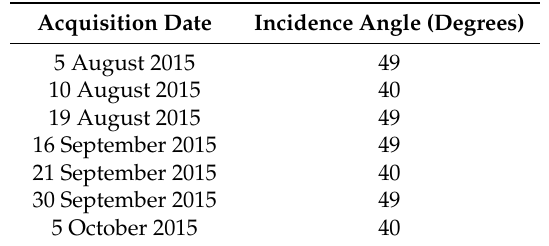
Table 2. Acquisition dates and incidence angles of PALSAR-2 Spotlight images used for the analysis of Tell El-Farama, Tell El-Mahzan, and Tell El-Kanais. All were acquired in descending node, right looking, and with HH polarization. See Table S3 of the Supplementary Materials for the scene IDs of individual